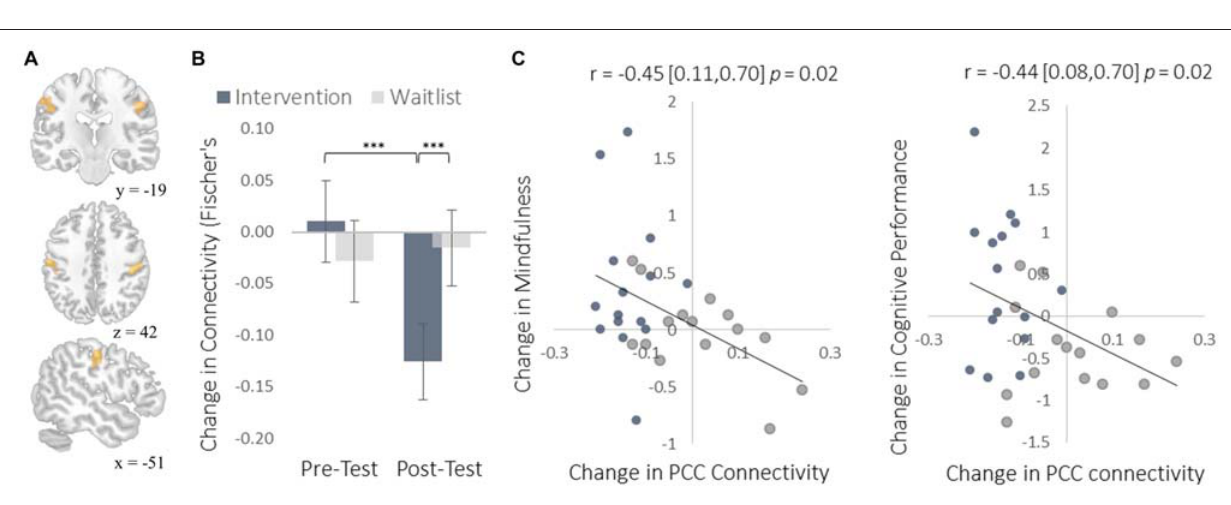
Eberth and Sedlmeier,